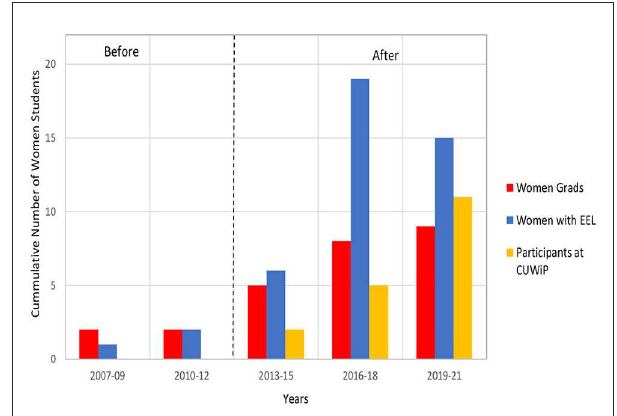
FIGURE5 Retention-to-Graduation for women in the Physics Group in comparison with EEL and CUWiP participation. Cumulative number of participants at the APS Conference for Undergraduate Women in Physics (CUWiP) by 3-year grouping. Prior to 2013, there was no CUWiP attendance in the Physics Group. If a participant attended more than once, it is only tallied at the first instance and suppressed for subsequent years. Multiple EEL for the same student were included in the tallies.